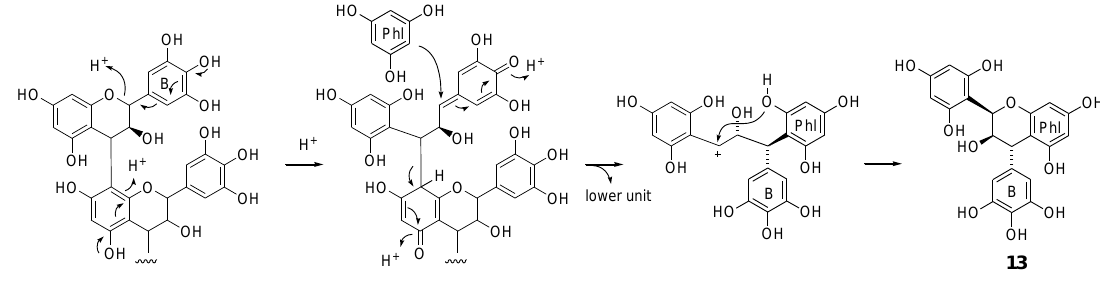
Figure 11. 1 H- 1 H COSY, HMBC, and NOESY correlations of 13 .